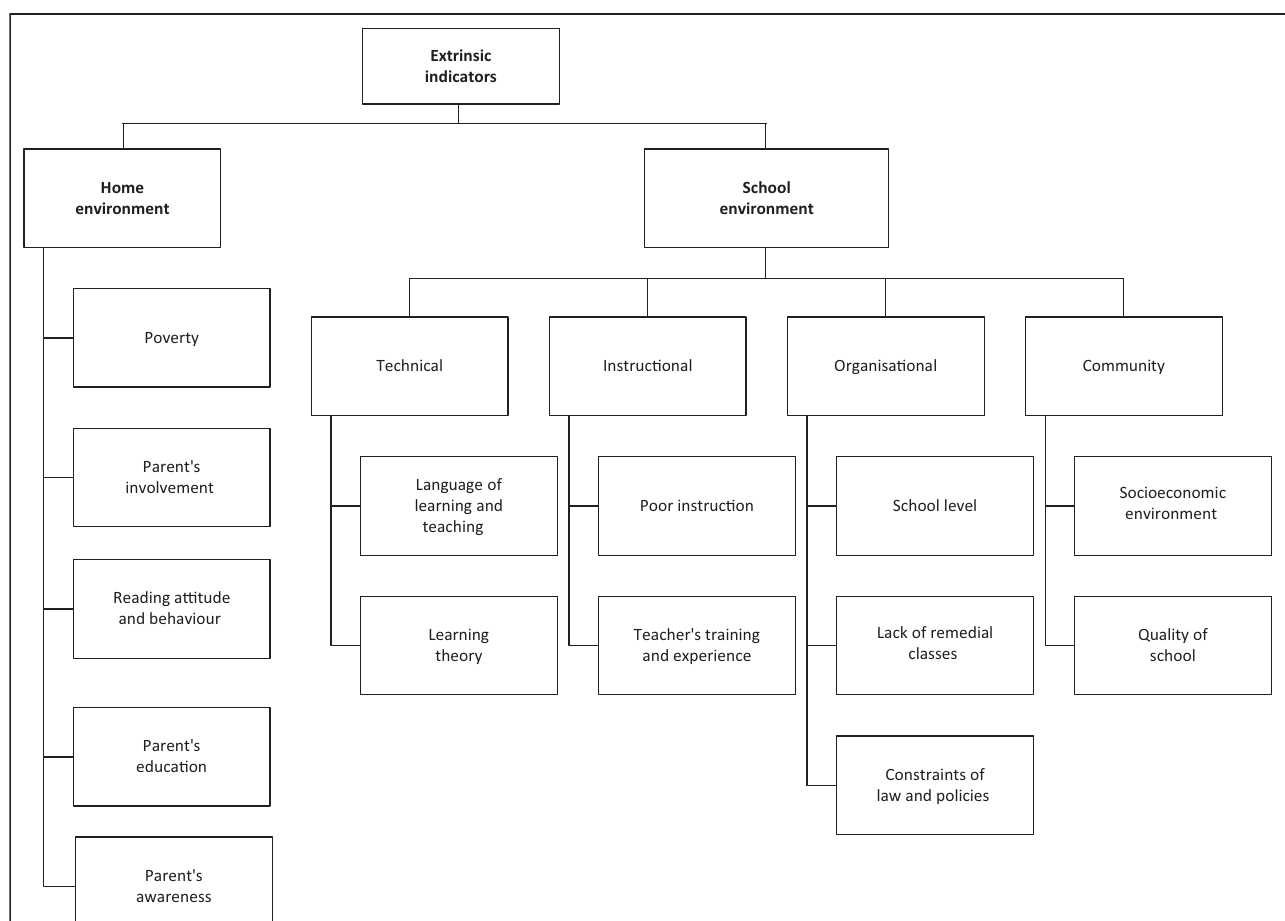
FIGURE 4: Extrinsic indicators of language-based learning